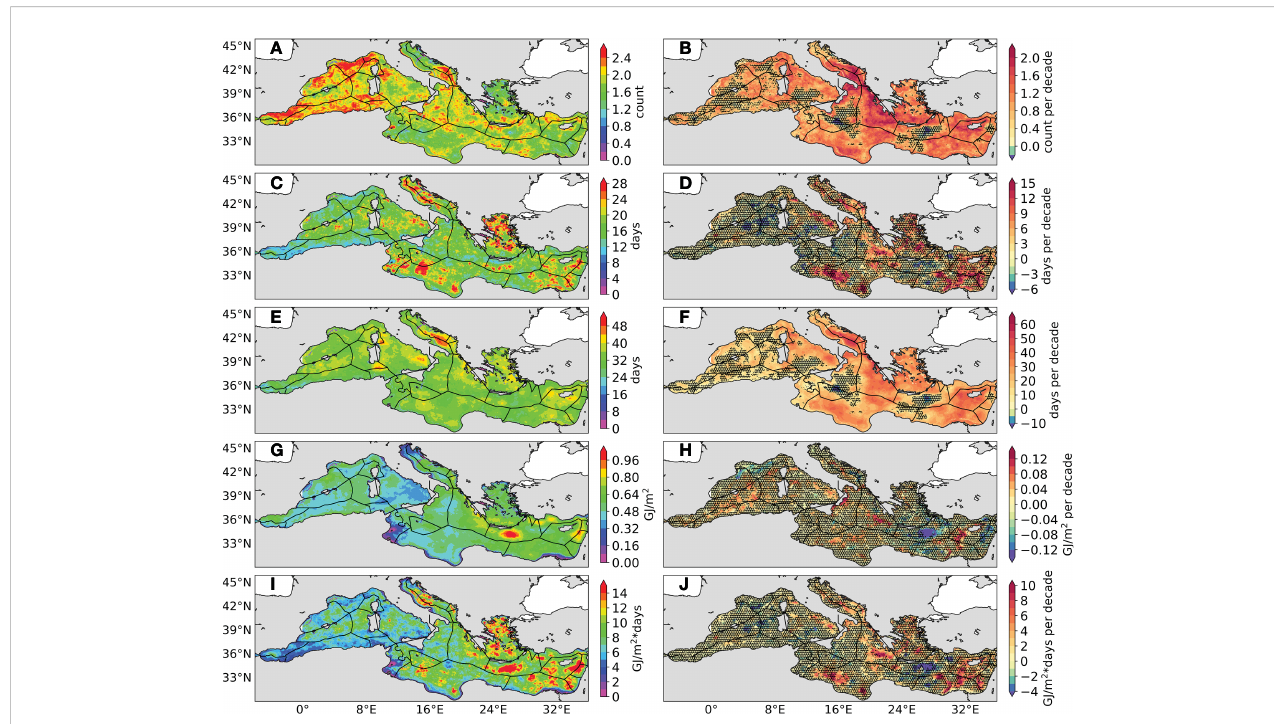
FIGURE 8 Means (Left panels, A, C, E, G, I ) and linear trends (Right panels, B, D, F, H, J ) from the OHC in the upper 100 m provided by MEDREA over the period 1987-2019 of annual MHW frequency ( A, B, in count), duration ( C, D, in days), total days ( E, F, in days), maximum intensity ( G, H, in GJ/m 2 ) and cumulative intensity ( I, J , in GJ/m 2 *days). The black line indicates the bathymetry. Black hatches indicate where trend values are not signi fi cant at the 95% con fi dence level based on a Mann-Kendall trend test. Results from the OHC in the upper 20 and 40 m are shown in the Supplementary Material (Figure 1S and Figure